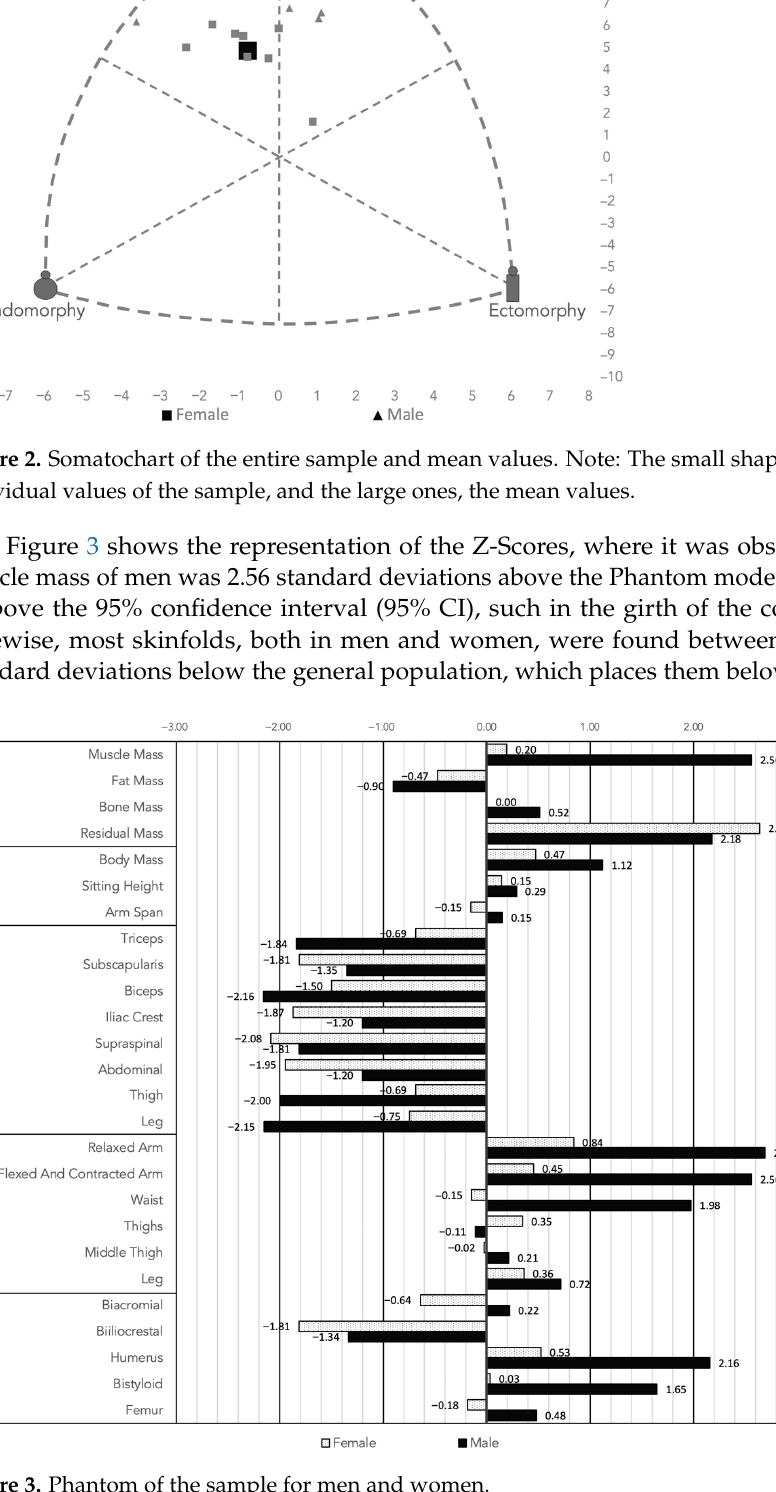
Figure 3. Phantom of the sample for men and women.